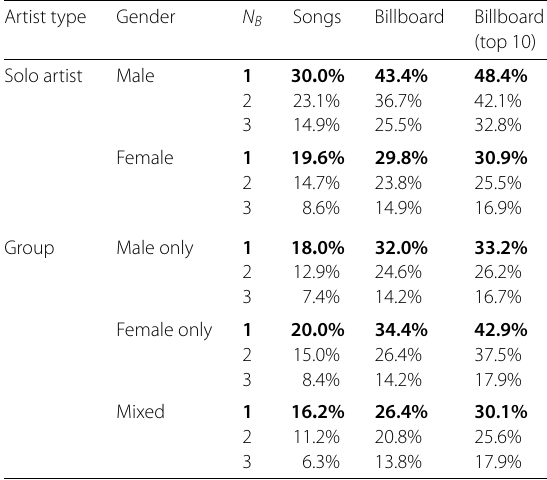
Table 6 Percentage of sexist songs identified for each artist type and gender. We report how these percentages change for different values of N B (i.e. the minimum number of 4 line batches classified as sexist to consider the whole song to contain sexist content). The classification threshold = 0.725 and values in bold are used in the main text. Percentages correspond to the fraction of sexist lyrics within the artist type and gender N